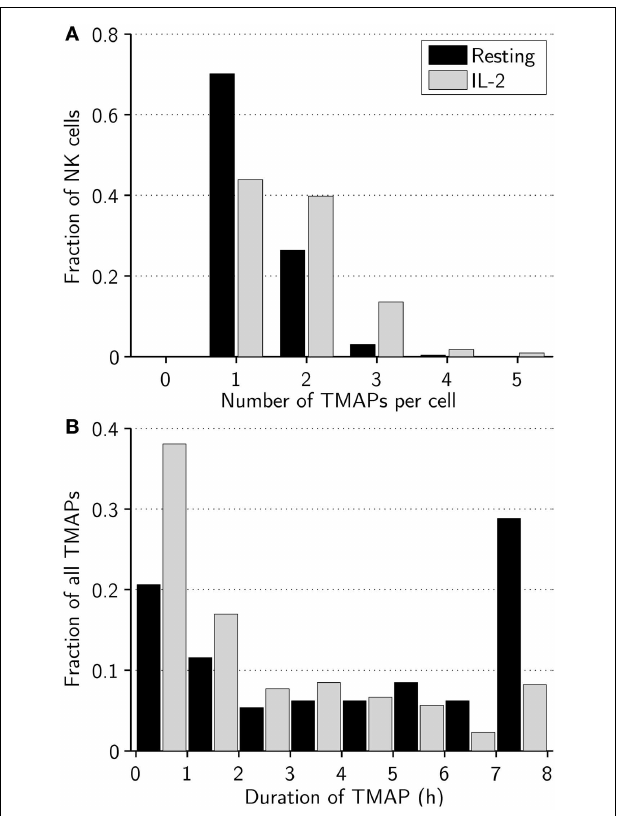
FIGURE 2 |Activated NK cells alter between different modes of migration more frequently than resting NK cells . (A) Distribution of number ofTMAPs recorded for individual resting (black bars) and activated (gray bars) NK cells.The number ofTMAPs detected was 354 for resting and 389 for activated NK cells. (B) Distribution of duration of individual TMAPs for resting (black bars) and activated (gray bars) NK cells.